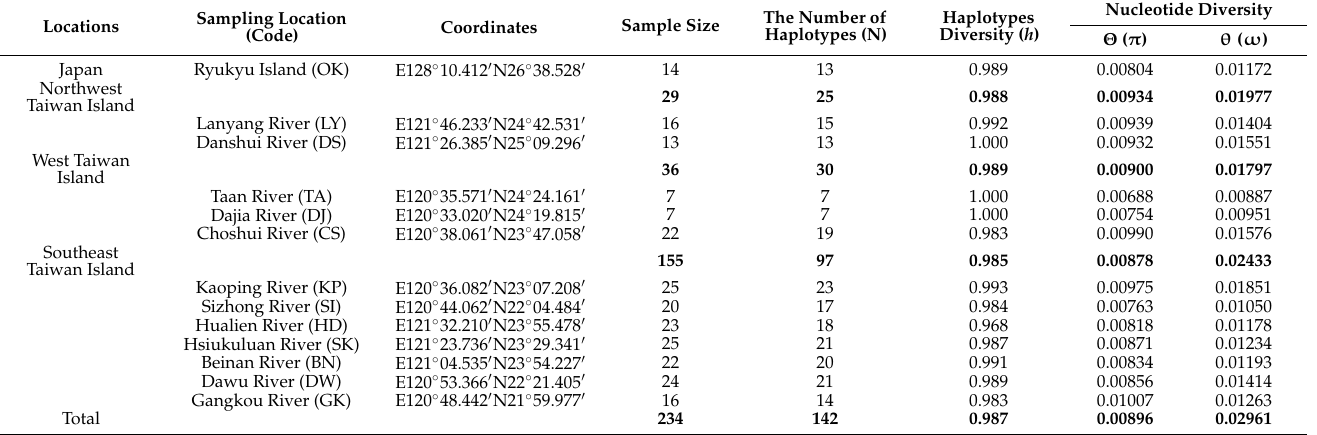
Table 1. List of sampling locations and the sample sizes, the number of haplotypes, haplotype diversities, and nucleotide diversities of the partial mtDNA COI region sequences for each